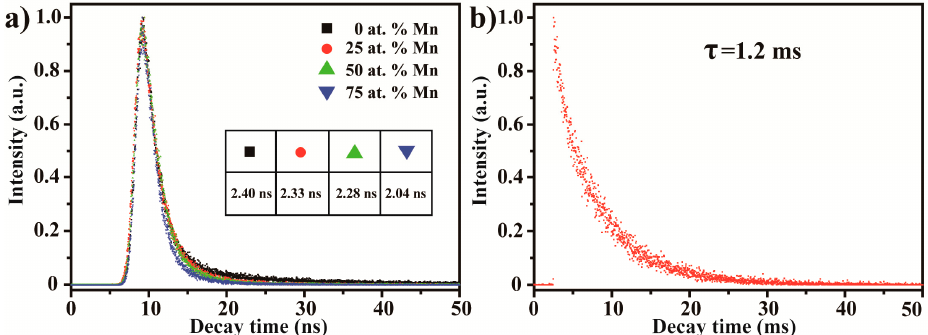
Figure 4. PL decay spectrum of Mn 2+ -doped CH 3 NH 3 PbCl 3 PNCs films prepared with different MnCl 2 concentration. ( a ) Monitored at exciton emission (~410 nm) and (b) Mn 2+ dopant emission of 50 at.% Mn (~610 nm).